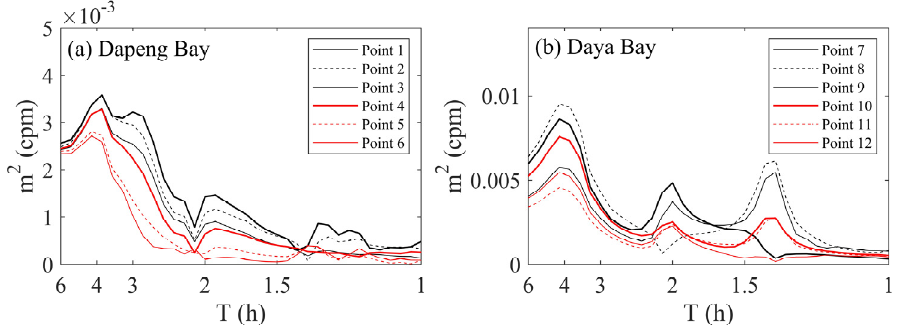
Figure 11. As in Figure 10 in ( a ) Dapeng Bay and ( b ) Daya Bay, except the direction of constant wind forcing is in the D–F direction.